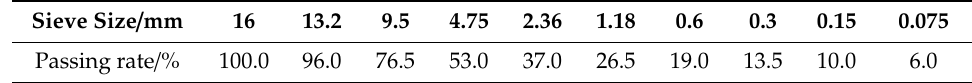
Table 2. Composition of the aggregate mixture.